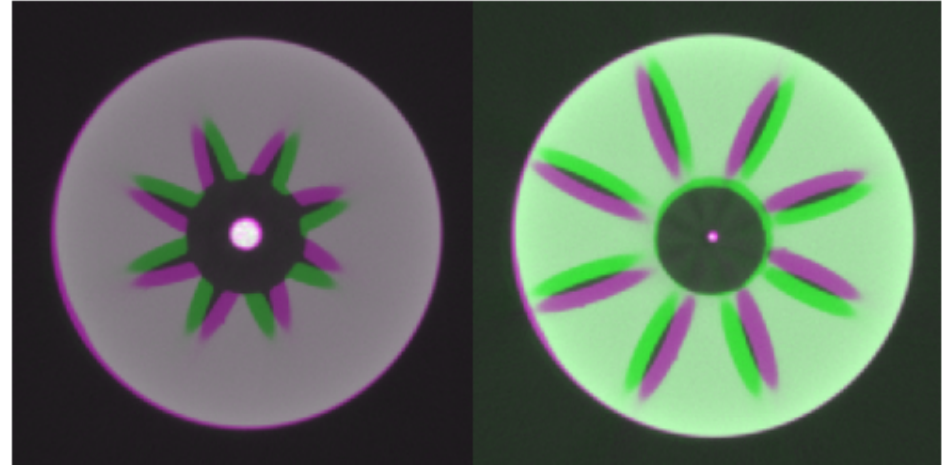
Figure 4. Overlapped cross section views of the nozzle area from the new and the aged injectors at different distances from nozzle tip. Purple: new injector. Green: aged injector.